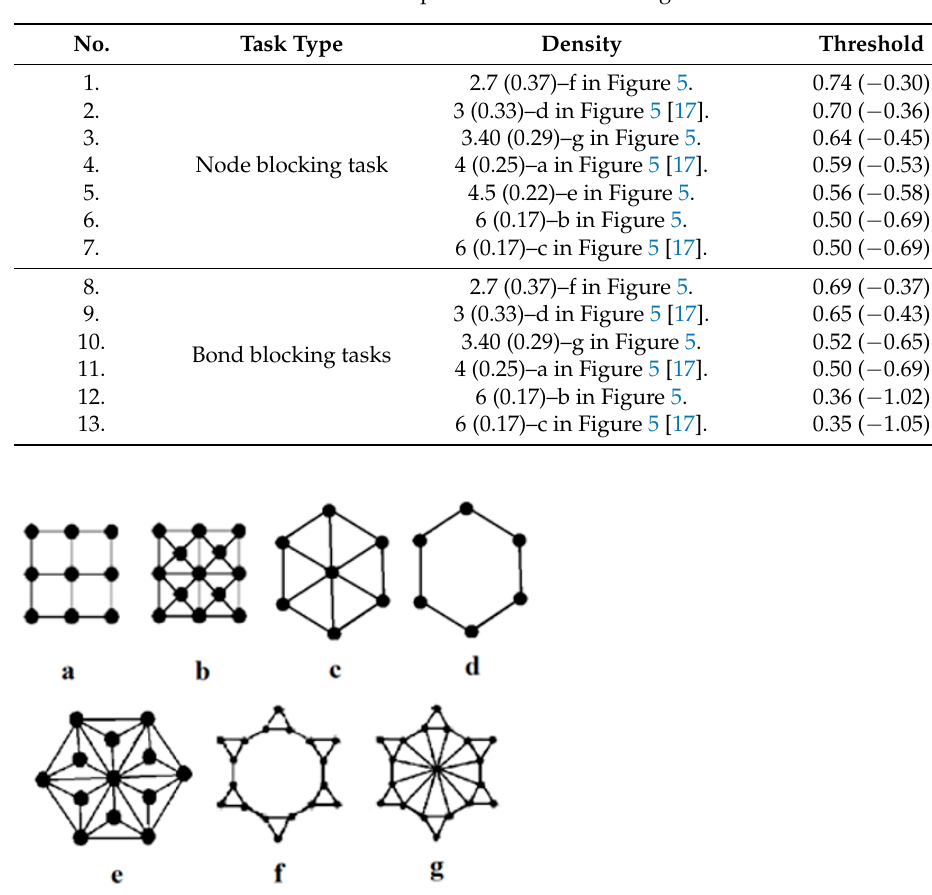
Table 2. Percolation threshold values for planar networks with regular structures.